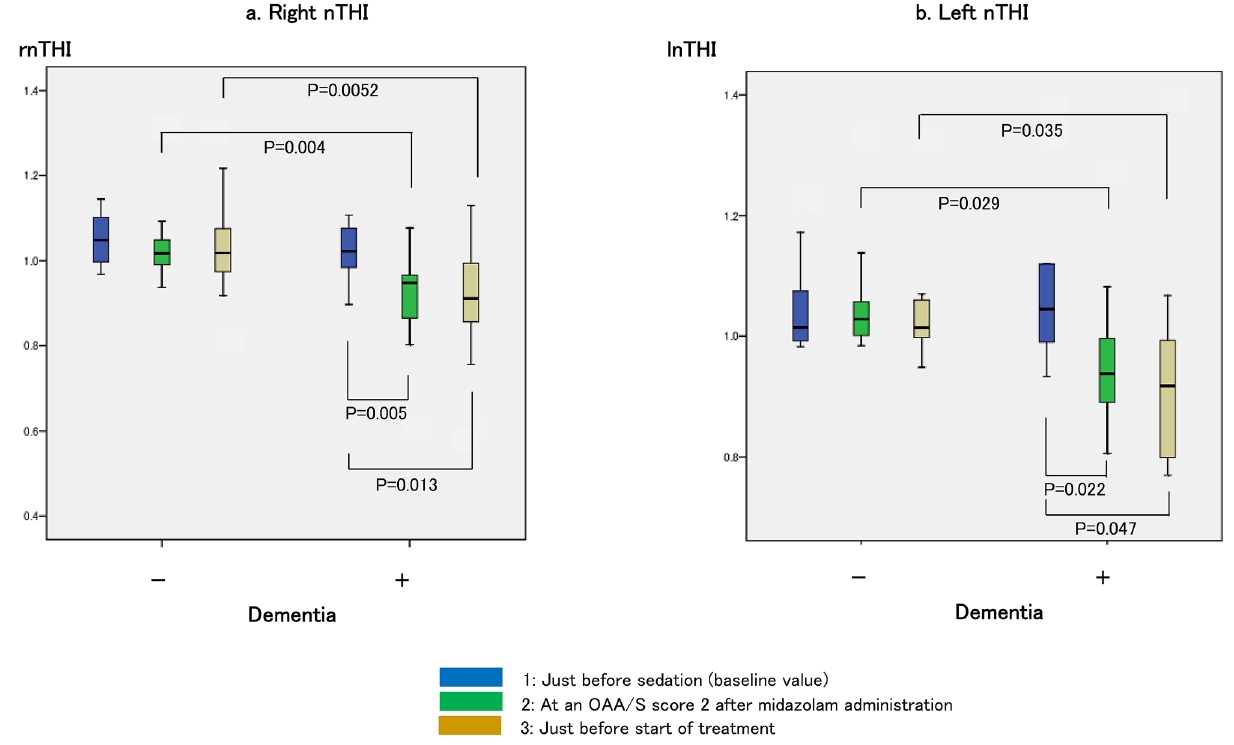
Figure 5. Changes in the normalized tissue hemoglobin index (nTHI). ( a ) indicates the right nTHI values: 1.05 (0.99–1.11) just before sedation (baseline value), 1.02 (0.99–1.06) when OAA/S score of 2 was achieved after midazolam administration, and 1.02 (0.96–1.09) just before the start of treatment in the dementia- negative group; 1.02 (0.98–1.08) just before sedation (baseline value), 0.95 (0.85–0.97) when OAA/S score